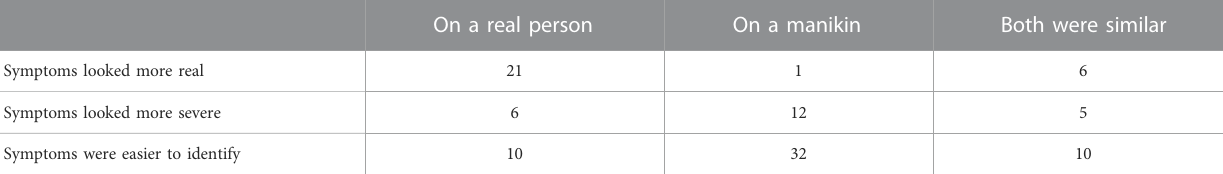
TABLE 5Summary of object fi delity qualitative results.The numbers in the table represent the count of participants who indicated a particular perception.Not all responses were relevant to the questions so the counts do not add up to the total number of responses.